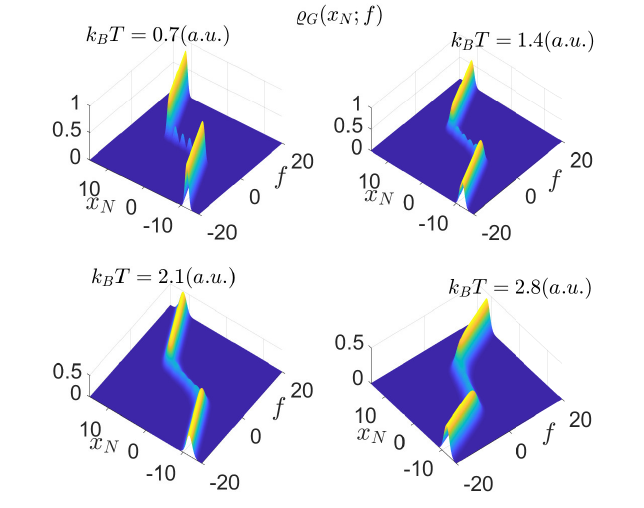
Figure 4. Three-dimensional representation of the Gibbs density (cid:36) G ( x N ; f ) (see Equation (33)) obtained with N = 5, (cid:96) = 1 (a.u.), k = 15 (a.u.) and k B T = 0.7, 1.4, 2.1, 2.8